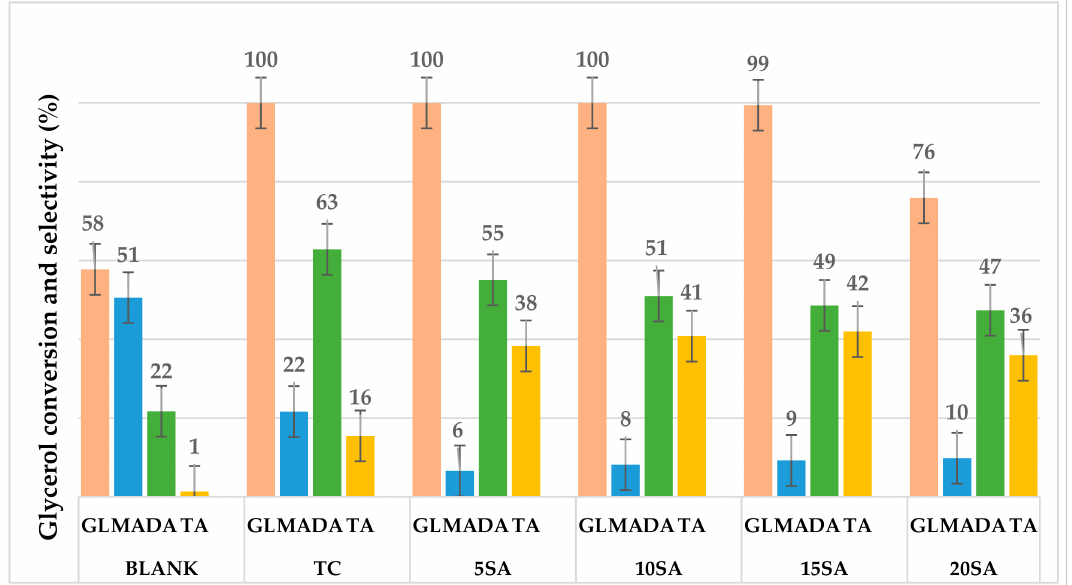
Figure 7. The glycerol conversion and product selectivity. Reaction condition: 1:6 w / v glycerol: acetic acid mole ratio (5 g glycerol, 18.6 mL acetic acid) 0.5 g catalyst loading, 100–120 ◦ C, 2–4 h, 450 rpm. GL: Glycerol conversion, MA: Monoacetin, DA: Diacetin, TA: